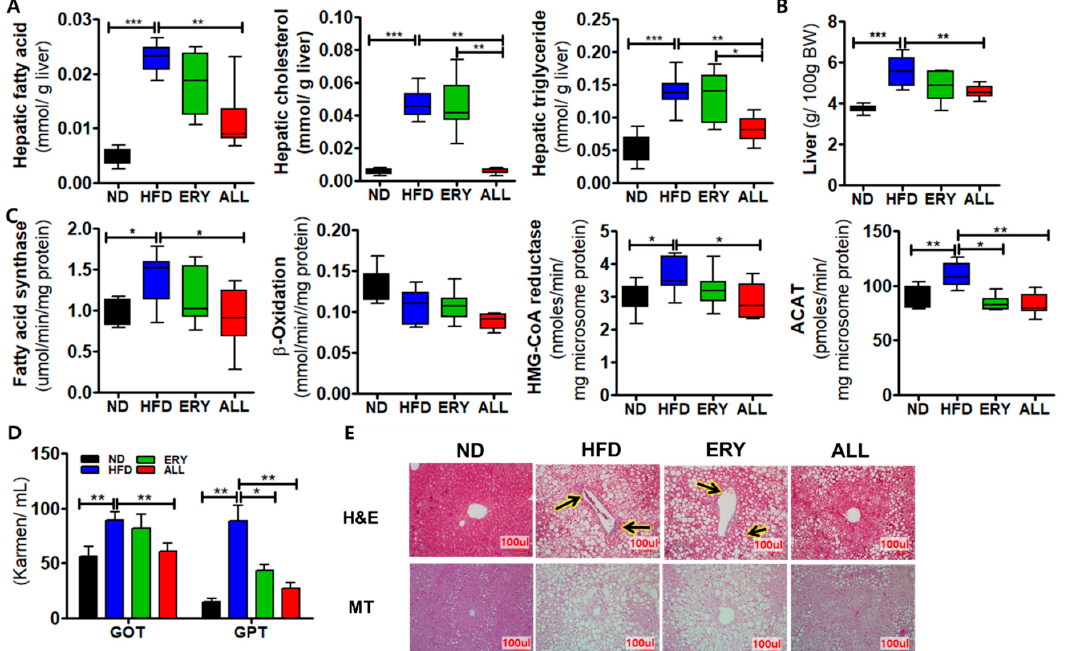
Figure 3. Effects of 16-week D-allulose supplement on hepatic steatosis-related markers in C57BL/6J mice fed a high-fat diet. ( A ) Hepatic lipid contents. ( B ) Liver weights. ( C ) Hepatic lipid metabolism-related enzyme activities. ( D ) Masson’s trichrome staining; ( E ) Plasma GOT and GPT levels; Data are